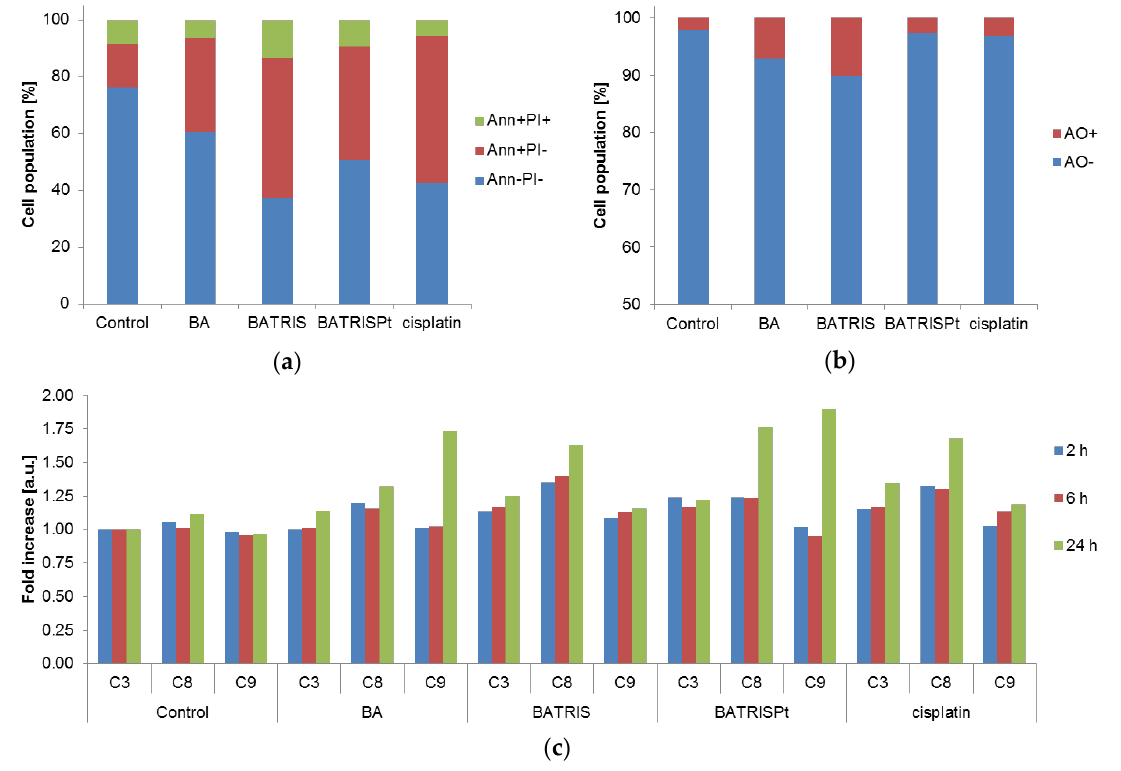
Figure 3. B16 cells treated with investigated compounds: ( a ) apoptosis; ( b ) autophagy; and ( c ) caspase activation.